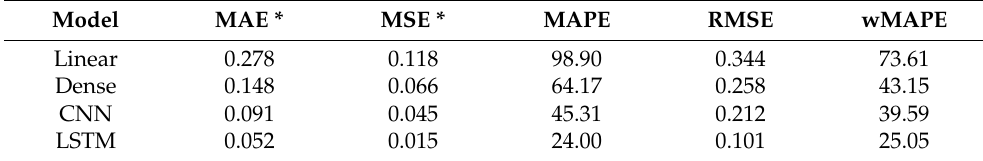
Table 3. The performances of presented models on db 1 considering different evaluation metrics.